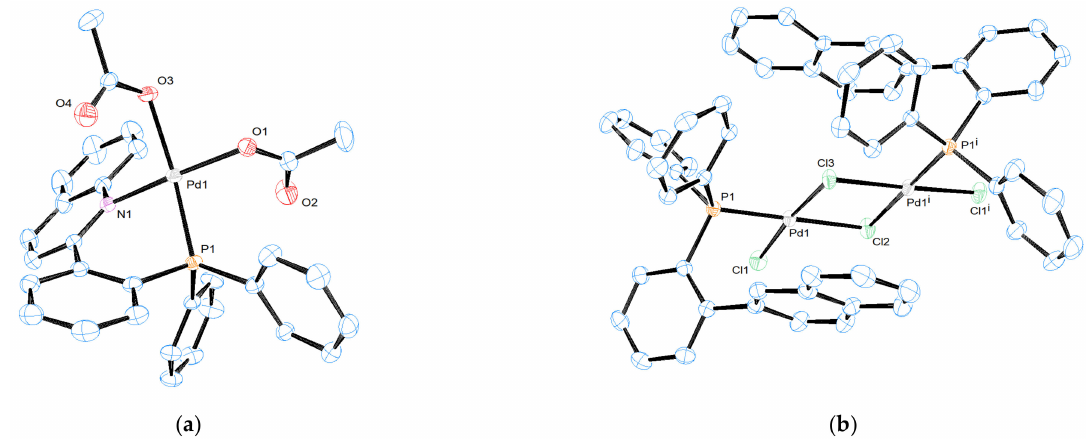
Figure 2. ORTEP drawing of Pd complexes. ( a ) Pd-NP-1. Selected bond lengths (Å): Pd(1)-O(1) = 2.0164(15), Pd(1)-N(1) = 2.0601(16), Pd(1)-O(3) = 2.0901(13), Pd(1)-P(1) = 2.1885(4); ( b ) Pd-CP-1. Selected bond lengths (Å): Pd(1)- P(1) = 2.2563(8), Pd(1)-Cl(1) = 2.2937(9), Pd(1)-Cl(3) = 2.3181(8), Pd(1)-Cl(2) = 2.4293(9), Cl(2)-Pd(1) i = 2.4293(9), Cl(3)-Pd(1) i 2.3181(8). H atoms are omitted for